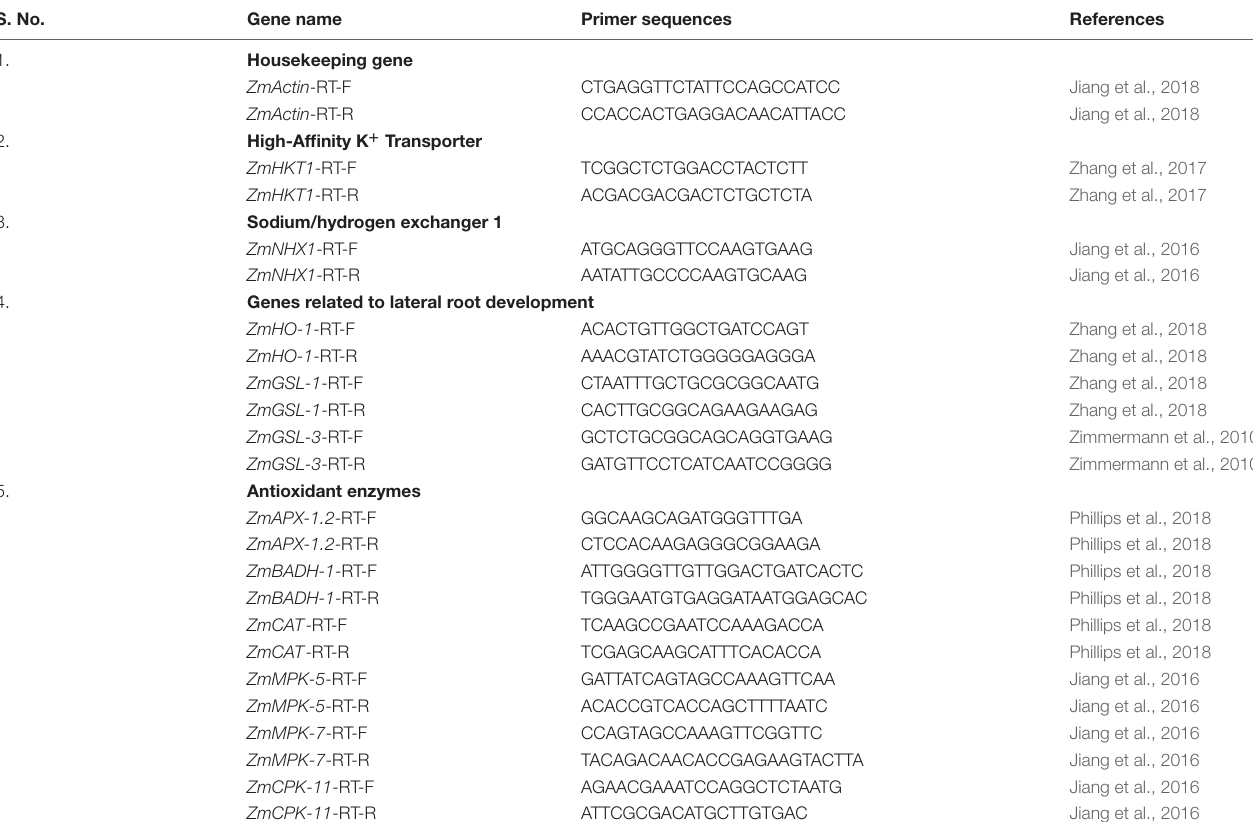
TABLE 1 | Primers used in qRT-PCR